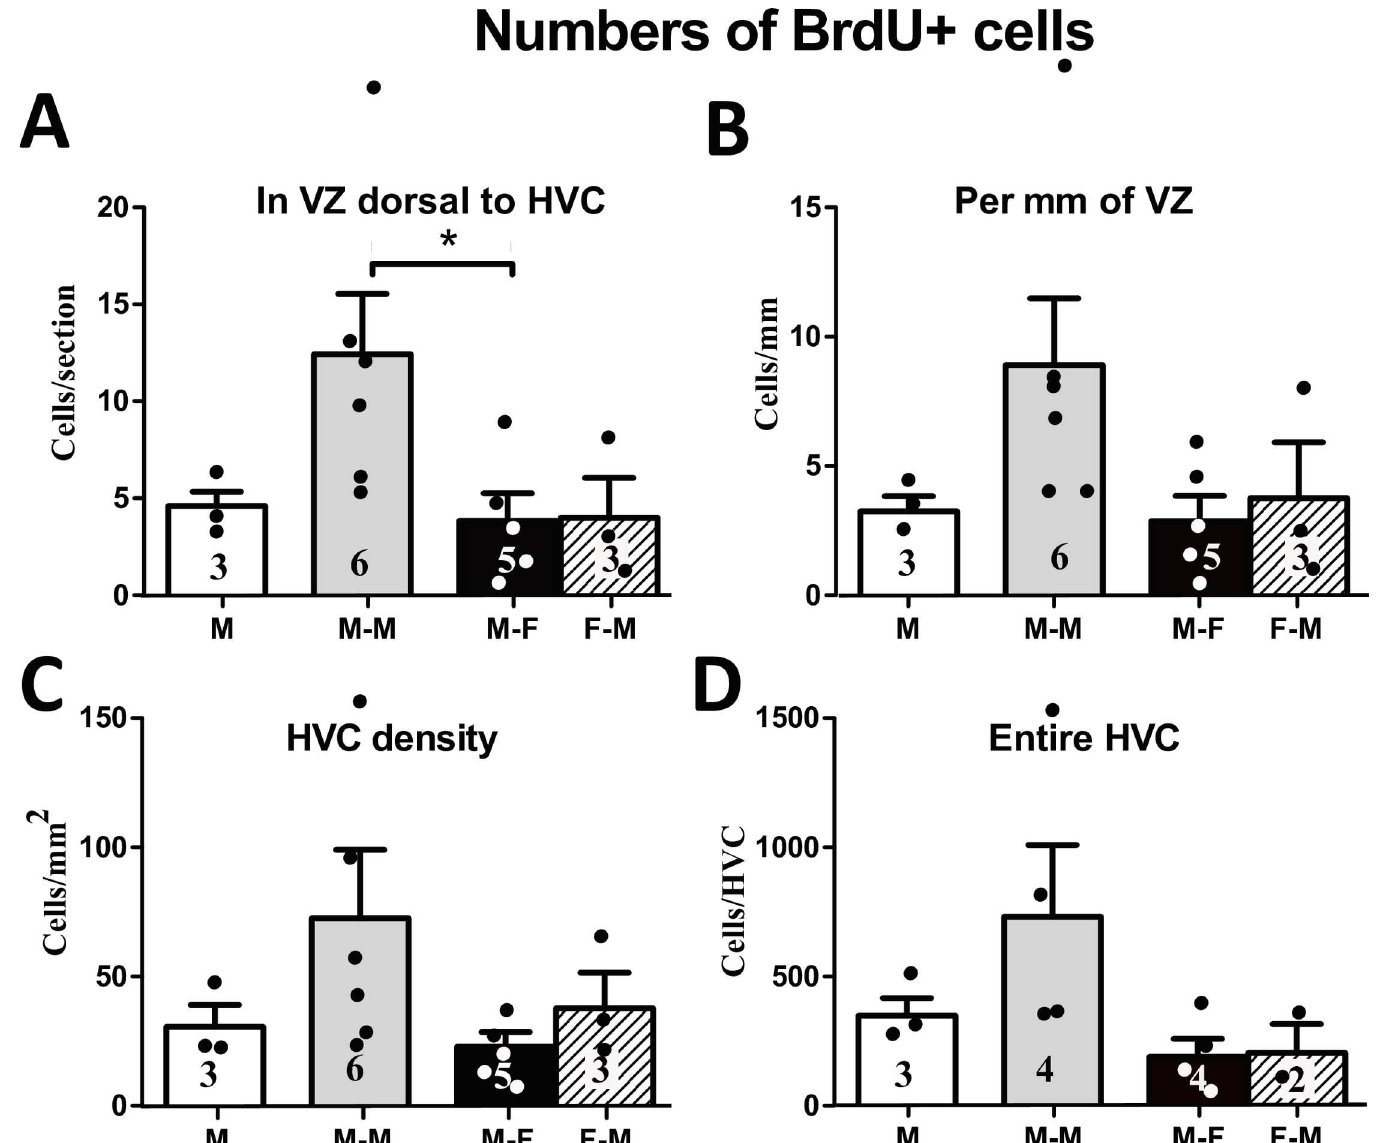
Fig 3. Number of BrdU + cells in the ventricular zone (VZ) dorsal to HVC as an absolute number per section (A) and normalized by the length of the VZ (B). Density (number per mm 2 ) of BrdU + cells in HVC (C) and number of BrdU + cells estimated for the entire HVC (D). M: male-alone,M-M: male housedwith another male, M-F: male housedwith female, F-M: female housedwith a male. The figures on the bars indicatethe numbers of available data points. * = p <